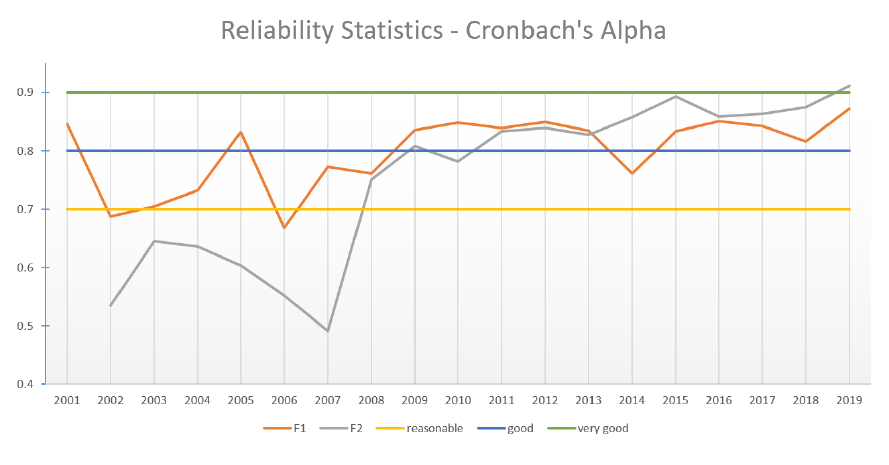
Figure 1. Reliability statistics—Cronbach’s alpha-number of